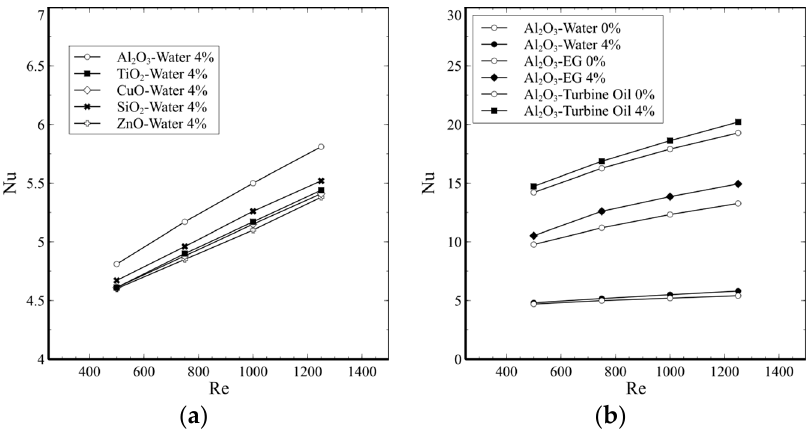
Figure 14. Comparison of Nu for ( a ) water-based nanofluids at φ b = 4%; ( b ) Al 2 O 3 -water, Al 2 O 3 -EG and Al 2 O 3 -turbine oil at φ b = 4%.